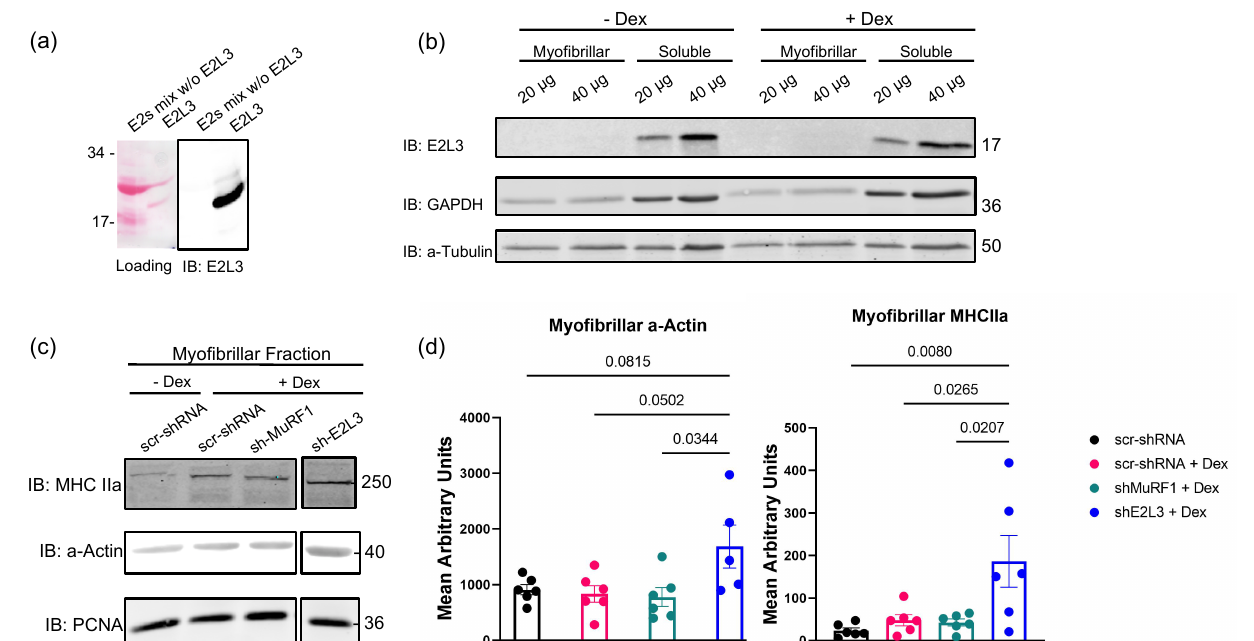
Figure 1. E2L3 knockdown preserved a-actin and MHCII in myofibrillar fraction in catabolic C2C12 myotubes. ( a ) A mixture of 11 recombinant E2 enzymes (E2 mix w/o E2L3) was used to address the selectivity of E2L3 antibody. A total of 1 µ g of each E2 enzyme was used. Only E2L3 was recognized by the antibody used. ( b ) E2L3 is mainly present in the soluble fraction of C2C12 myotubes. C2C12-soluble and myofibrillar-enriched fraction were assayed for E2L3, GAPDH and alpha-tubulin (a-tubulin) by immunoblotting (IB) (20 and 40 µ g of total proteins were loaded). GAPDH was used as marker of soluble-enriched fraction and a-tubulin as loading control. ( c ) Myofibrillar proteins were assayed for a-actin and MHCIIa levels by immunoblotting (15 µ g of total proteins were loaded). C2C12 myotubes were cultured in 24-well plates, treated with Dex 1 µ M and electroporated, as explained in Section 2, with two shRNA directed against E2L3 or MuRF1. ( d ) Densitometry analysis was performed on data from ( c ). Values were expressed after normalization with the loading control PCNA. Values are means SEM for n = 4 to 6 per group; p -values are indicated within the